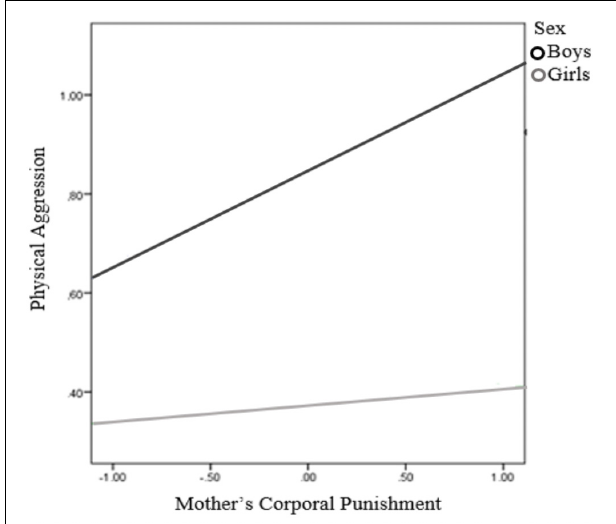
FIGURE 5 | Child’s sex as a moderator between mother’s corporal punishment and physical aggression.